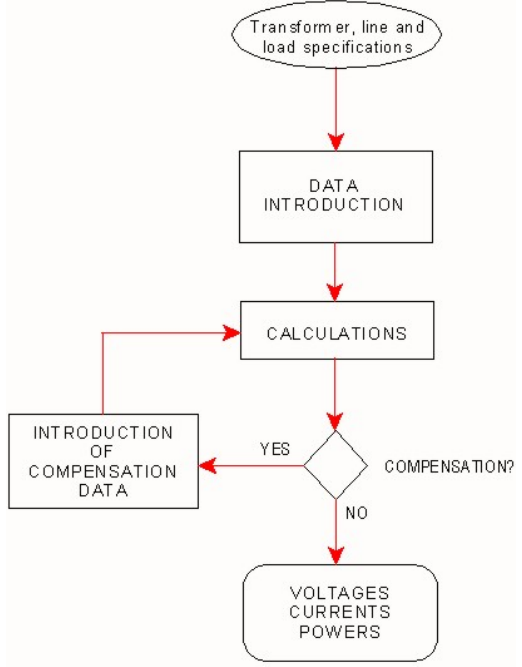
Figure 1. Four-wire delta (4WD) service simulator main page: ( 1 ) transformer, line and load specifications; ( 2 ) scheme; ( 3 ) compensation area; ( 4 ) transformer, line and load powers; ( 5 ) transformer voltages and currents; ( 6 ) line and load voltages and currents. “####” is infinite value.